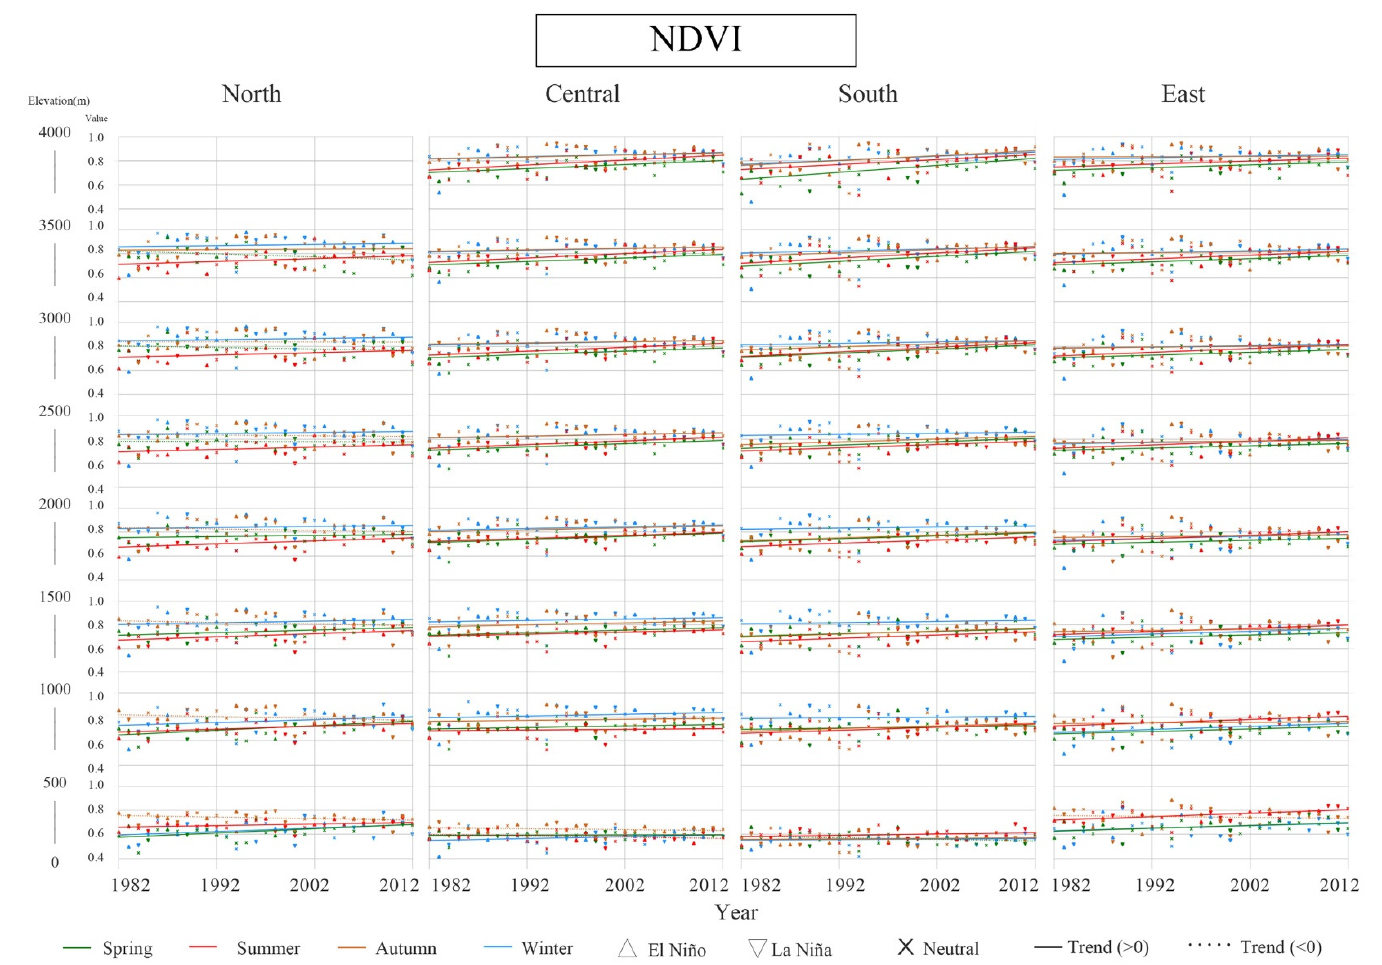
Figure 9. Regional and seasonal linear regression results for NDVI at varied elevations.